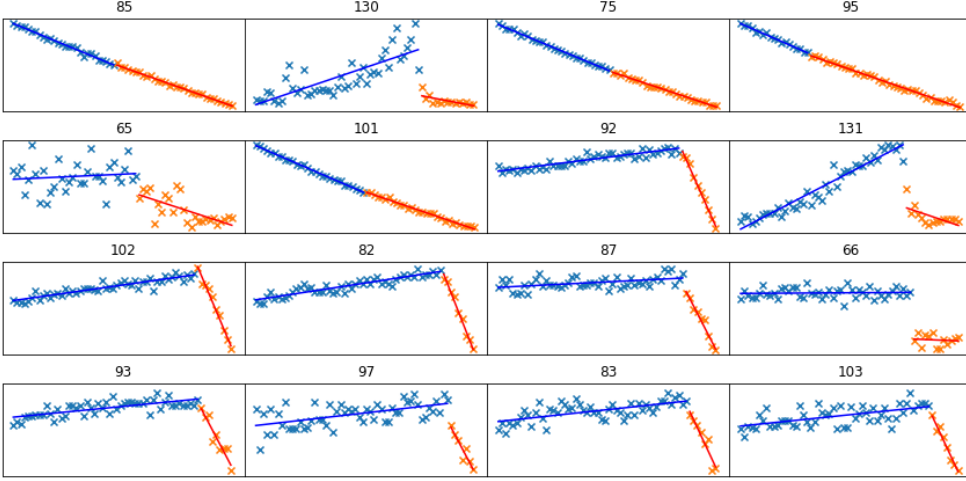
Figure 19. The linear fitting of 16 abnormal variables when t = 710 min in Mode 4.